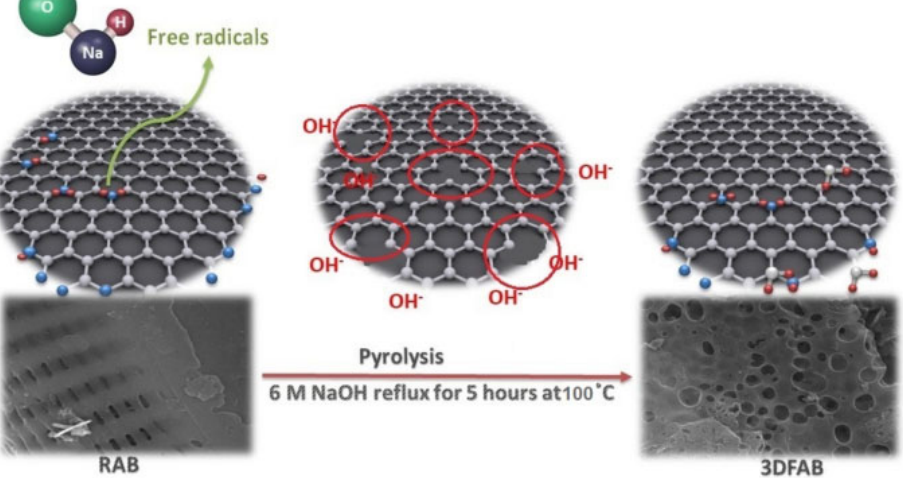
Figure 10. Alkali activation mechanism prior to synthesize metal oxide-loaded BC. Reprinted with permission from Ref. [171]. Copyright © 2021 Springer